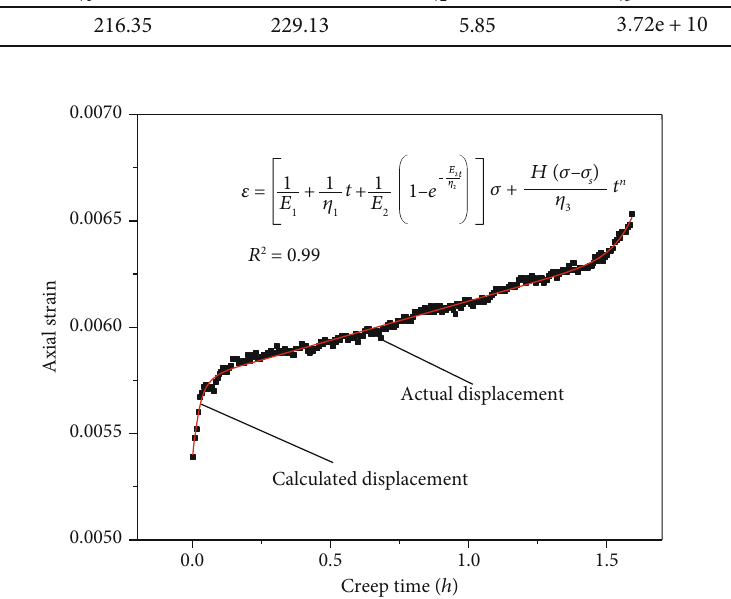
Table 6: Parameters of tertiary stage creep of the improved nonlinear viscoelastoplastic rheological model based on the burgers model. σ 3 (MPa)